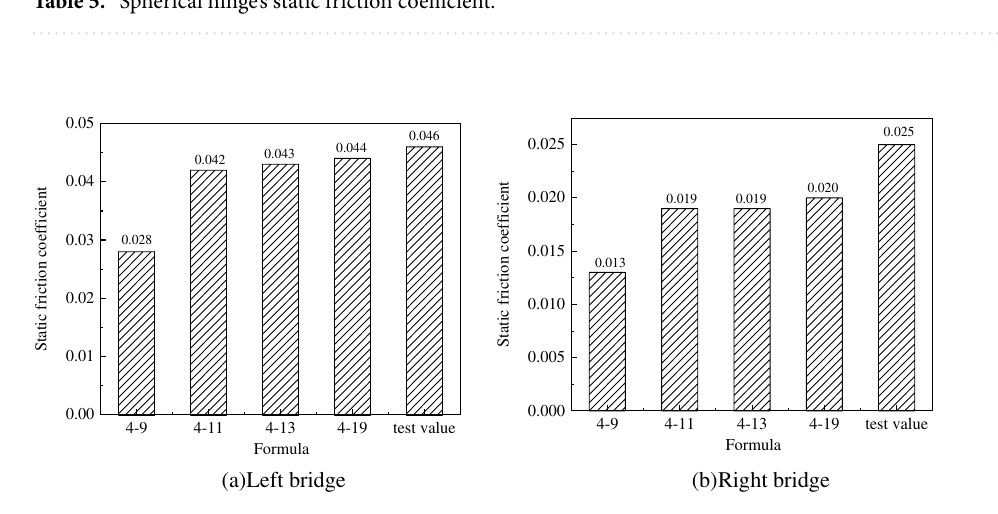
Figure 14. Comparison of calculated values of different